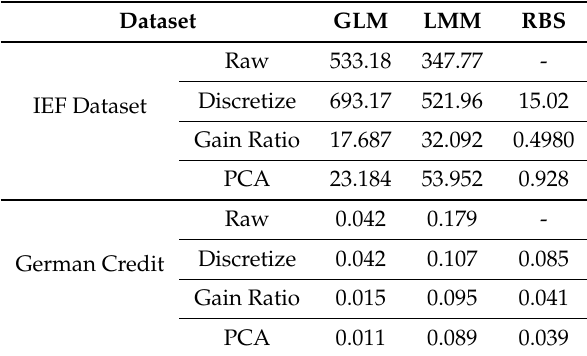
Table 6. Execution times (in s).